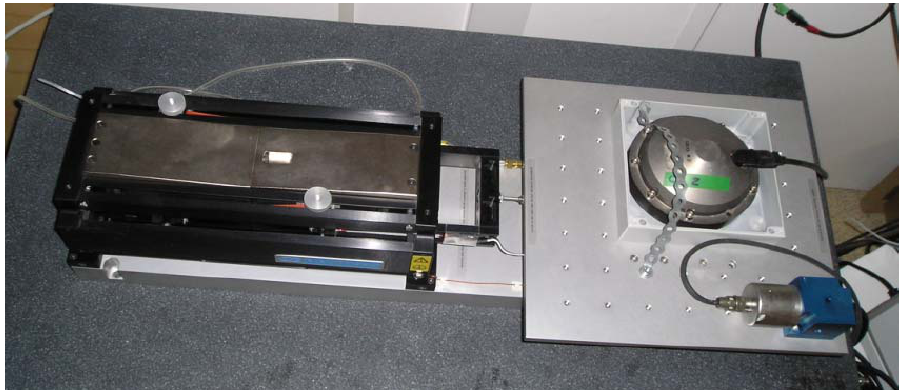
Figure 12. Shaker table with geophone and